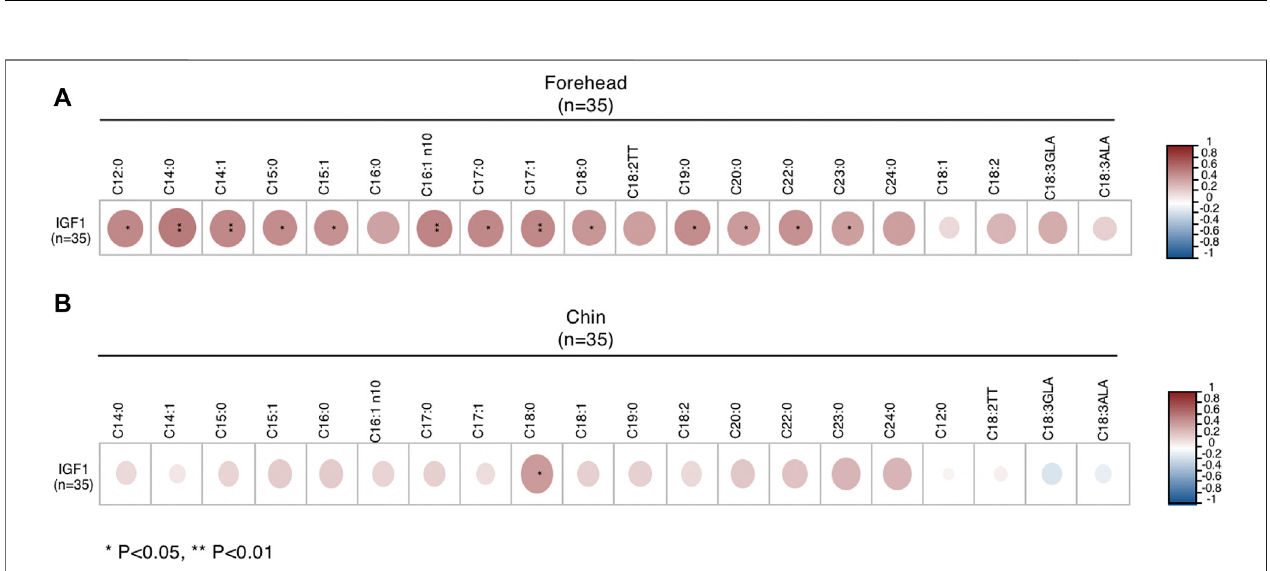
Frontiers in Physiology |